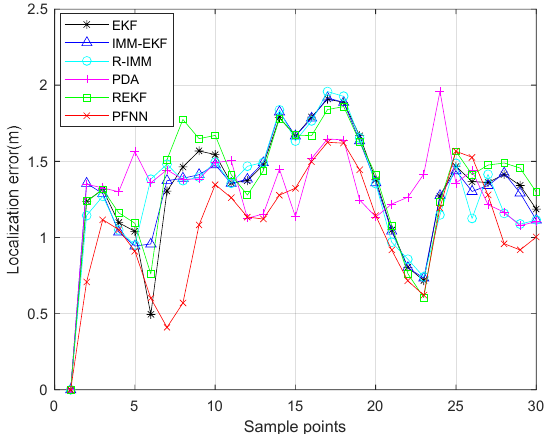
Figure 12. Each sampling point’s localization error.